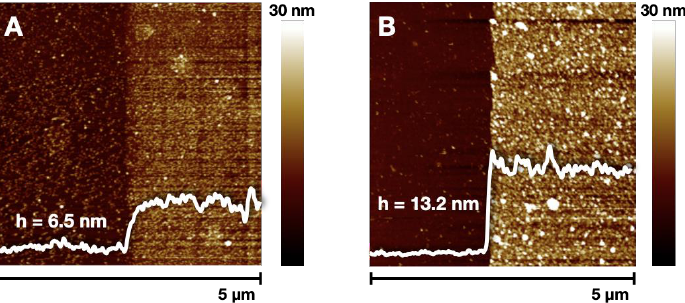
Figure 2. AFM pictures of polymer brushes with 80% grafting density on a silica substrate obtained via Sonogashira coupling and their thicknesses determined at the edges of the layers: ( A ) after deposition of 5 layers, ( B ) after deposition of 10 layers.